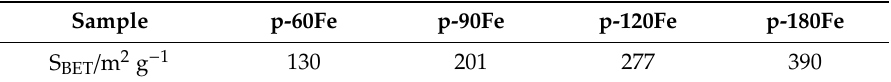
Table 3. The specific surface area of the prepared composites.